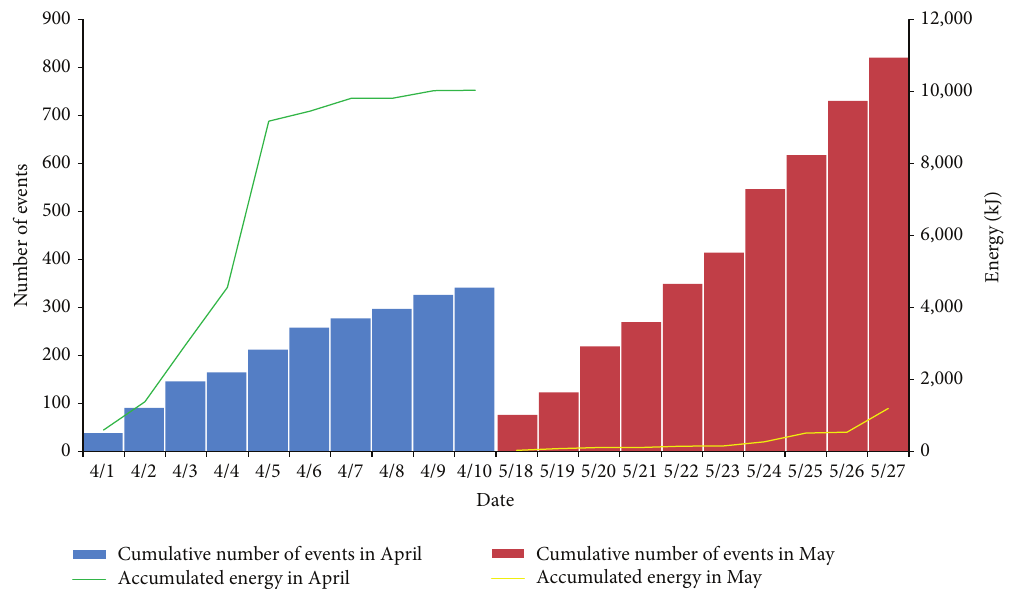
Figure 7: Comparison of cumulative number of microseismic events and accumulated energy before and after